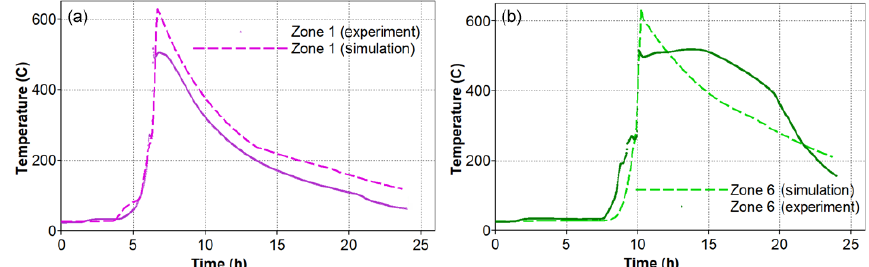
Figure 4. Temperature profiles: Zone 1 (a) ; Zone 6 (b) .